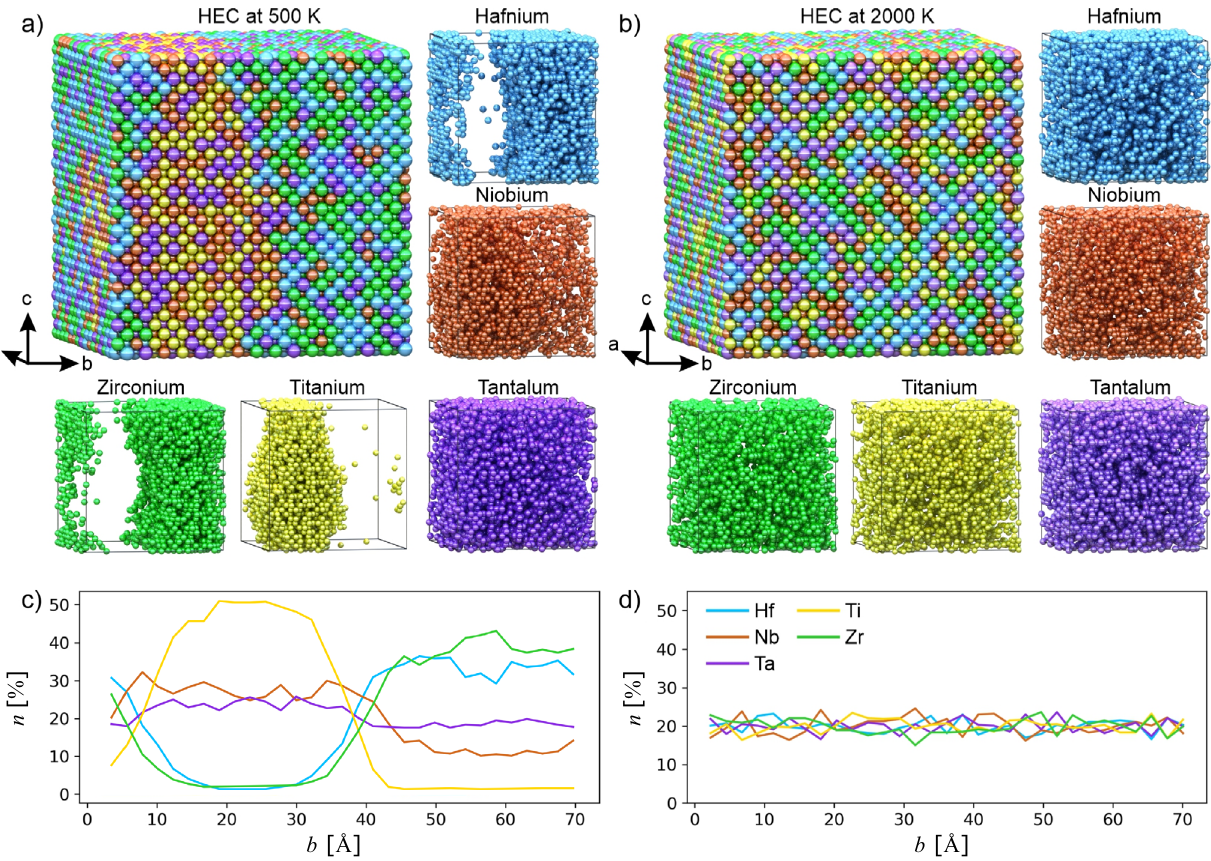
Fig. 2 Distribution of metal atoms in considered models of HEC. Crystal structures of the simulated 16 × 16 × 16 supercell of a multi- and b single-phase (Ti-Zr-Nb-Hf-Ta)C at 500 and 2000 K, respectively. Carbon atoms are not shown here explicitly to make the distribution of metal atoms clearer, while carbon atoms were considered in the CMC simulations; c , d relative concentration of chemical elements per layer along the supercell vector b